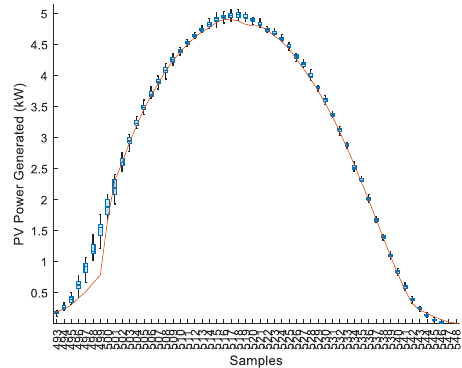
Figure 27. Power generated detail. Measured values (red) and one-step-ahead box plot of (cid:26) (cid:27) ε PHMOGA ( 25 ) M (blue). 4